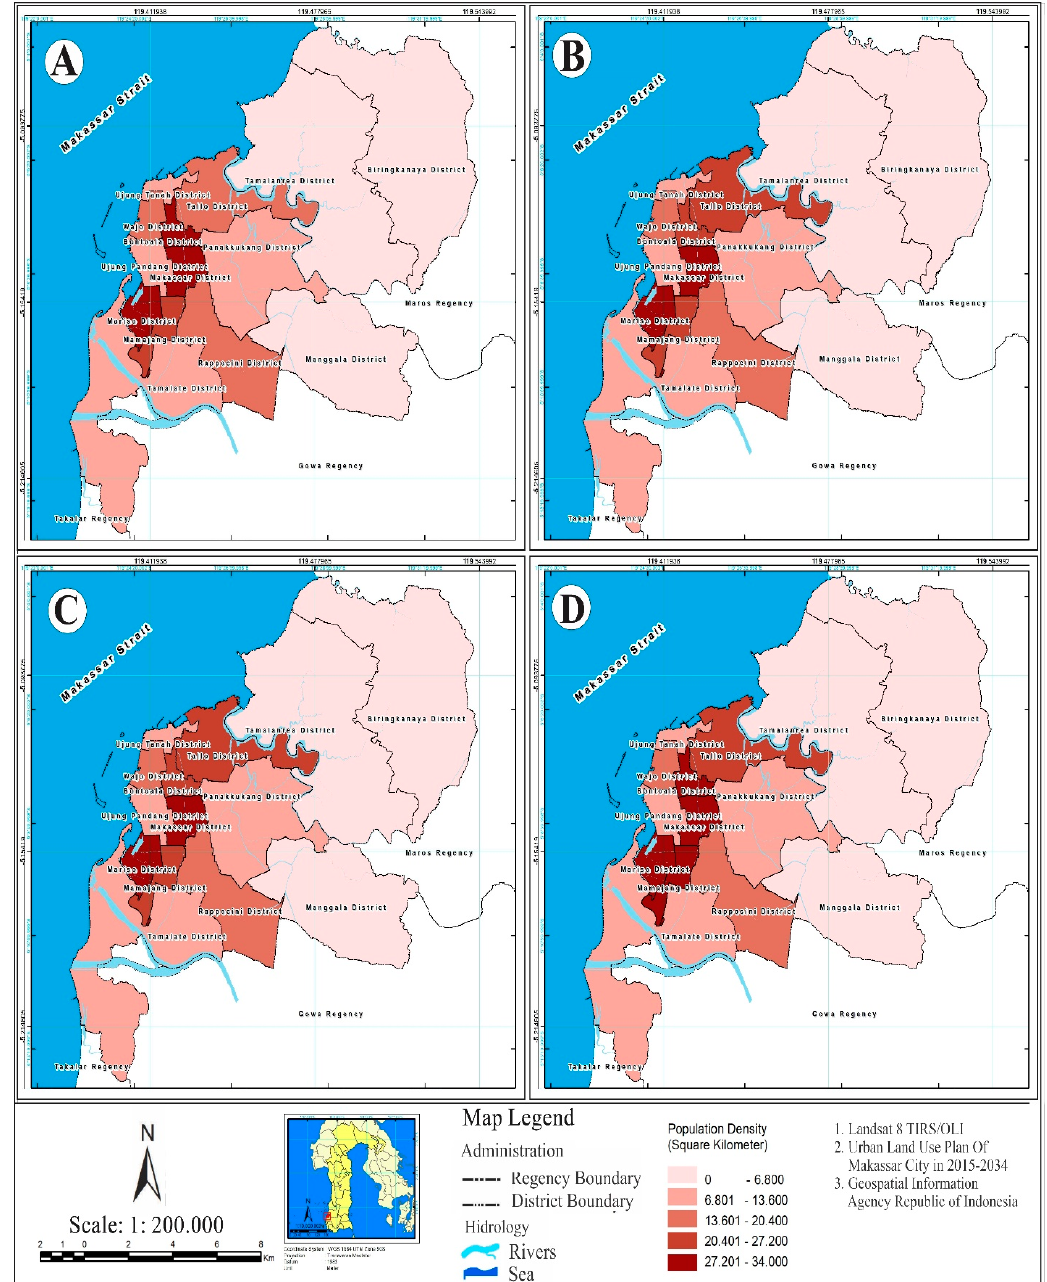
Figure A1. Population density of Makassar City by district: ( A ) in 2006, ( B ) in 2010, ( C ) in 2015, and ( D ) in 2020.